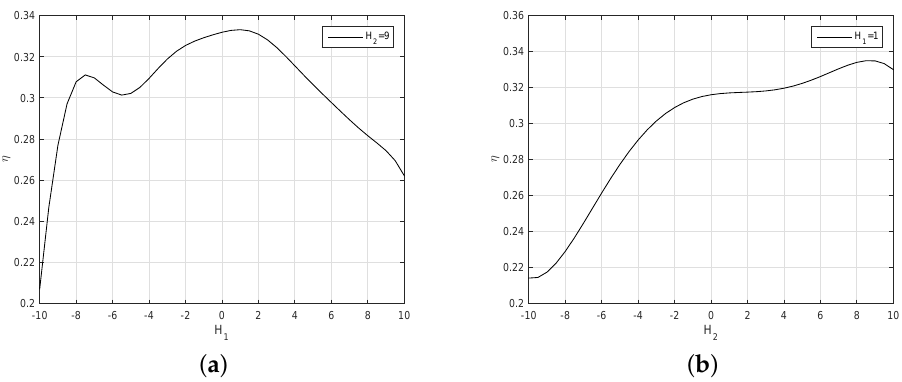
Figure 17. The efficiency of the robotic fish to H 1 and H 2 . ( a ) The changing of efficiency along with the variation of H 1 when H 2 = 9. ( b ) The changing of efficiency along with the variation of H 2 when H 1 =